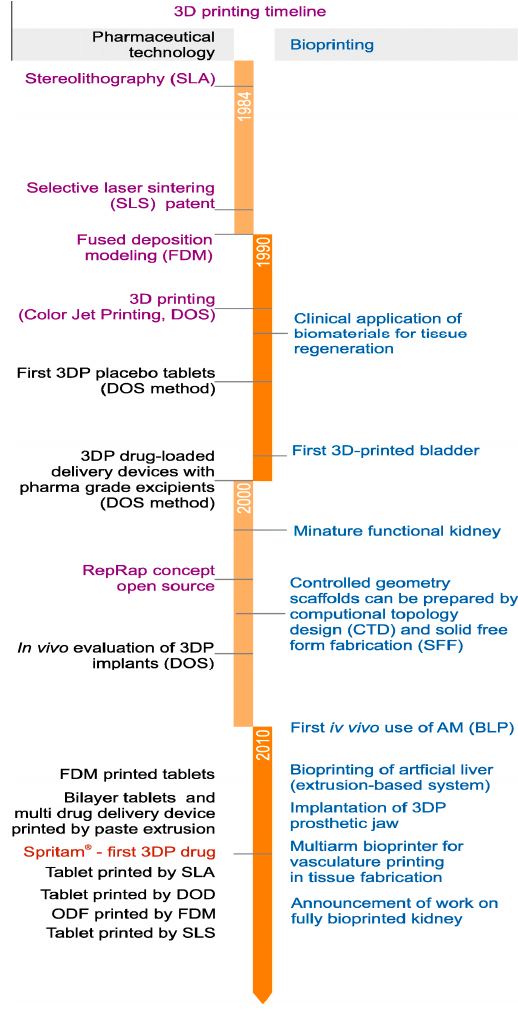
Figure 12. Bioprinting evolution timeline [67].